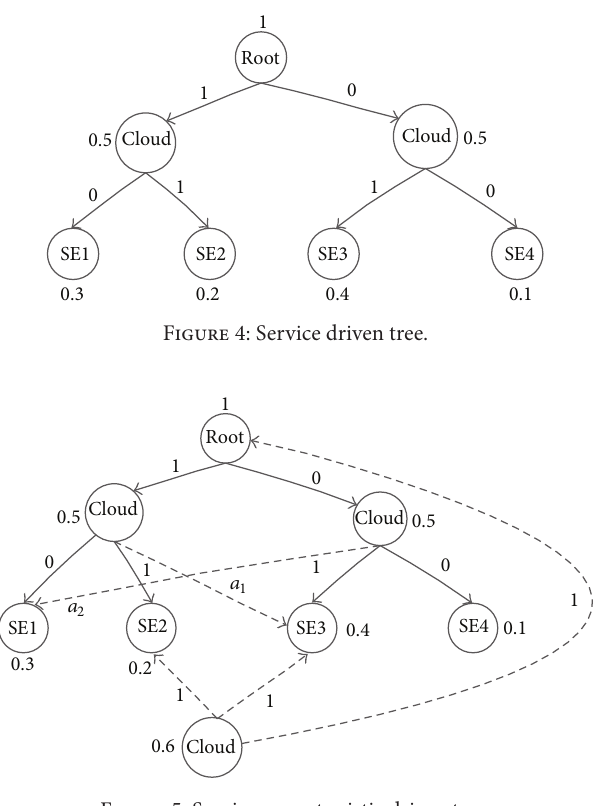
Figure 5: Service opportunistic driven tree.